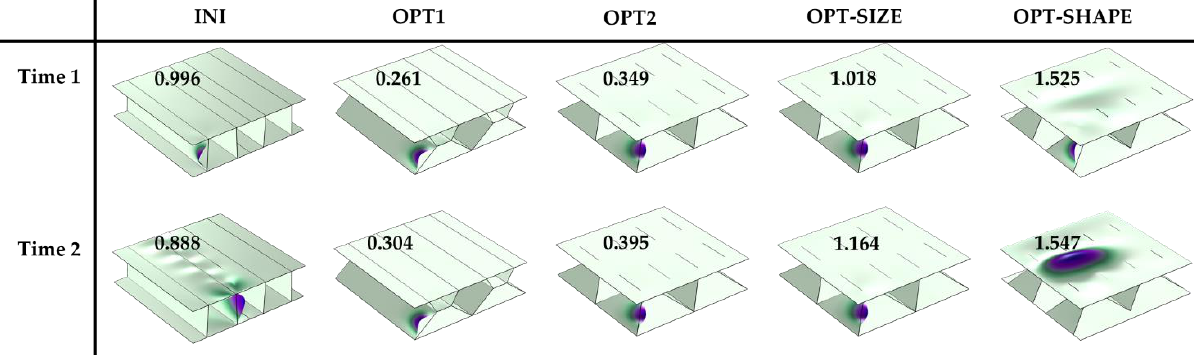
Figure 12. Buckling modes of initial structure and optimized models at Times 1 and 2.